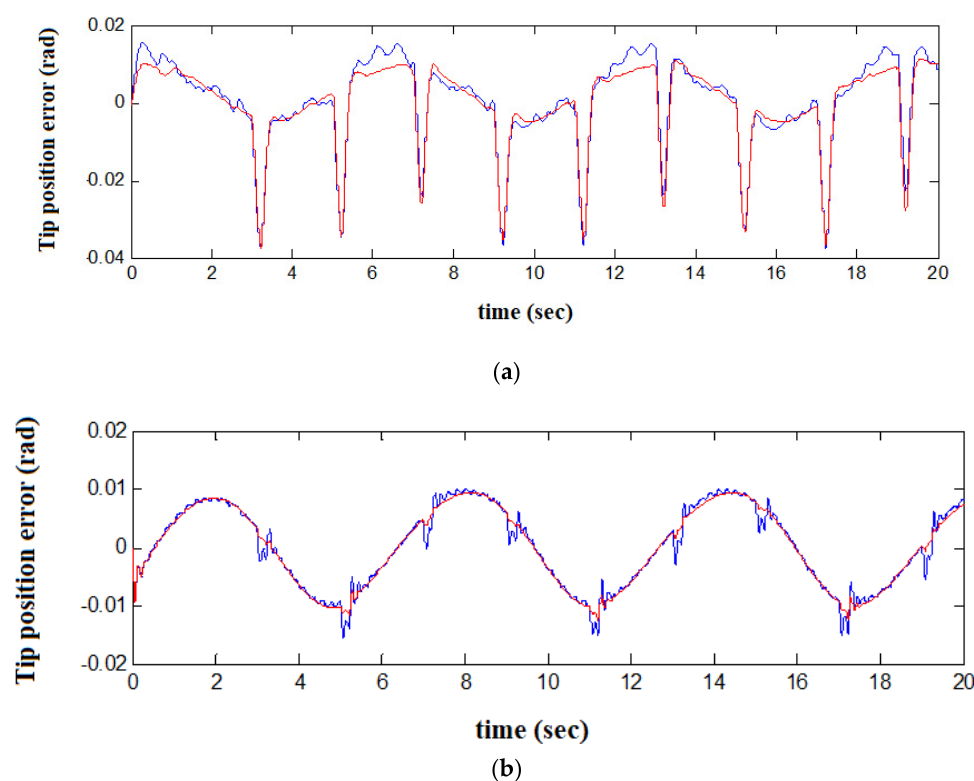
Figure 7. ( a ) The tracking control performance of the PD-based adaptive control laws; and ( b ) the tracking control performance of the proposed SMC-based adaptive control laws for a sinusoidal type endpoint reference. (Blue: with torque ripple, Red: without torque ripple).